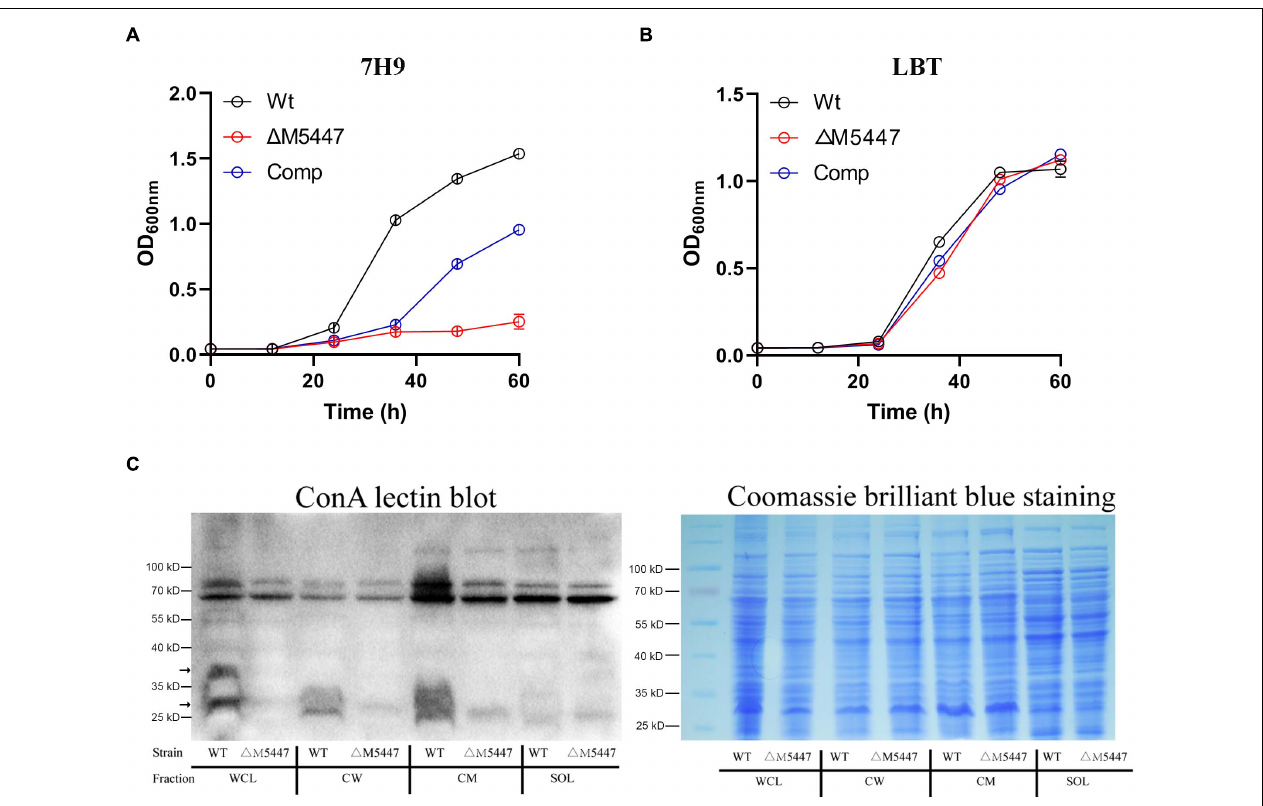
FIGURE 2 | Protein O-mannosyltransferase (PMT) deficiency impaired the growth of M. smegmatis and reduced its level of O-mannosylation. Wild-type M. smegmatis mc 2 155 (Wt) strain and MSMEG_5447 gene knockout strain ( (cid:49) M5447) and Comp strain were grown in LBT medium (A) or Middlebrook 7H9 medium supplemented with 10% ADC and 0.05% Tween 80 (B) ; the growth rate of bacteria was evaluated by measuring OD 600 at an interval of 12 h. (C) Wt and (cid:49) M5447 strains were grown in LBT broth. After the bacterial pellet was lysed by sonication, whole-cell lysate (WCL), CW, CM, and soluble (SOL) fractions were separated by differential centrifugation. The level of O-mannosylation of proteins in each subcellular fraction was analyzed by ConA lectin blotting (Left). The gels stained with Coomassie brilliant blue showed the same loading amount between different samples (Right). The black arrows for the band indicate the different levels of O-mannosylation in fractions of Wt and (cid:49) M5447